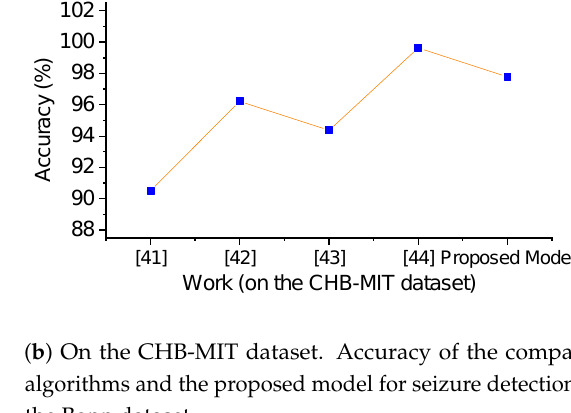
( a ) On the Bonn dataset. Accuracy of the compared algo- rithms and the proposed model for seizure detection on the Bonn dataset. Figure 5. Algorithm comparison. The accuracy of the compared algorithms and the proposed model for seizure detection on the two datasets. The x -axis is for each algorithm and the y -axis for